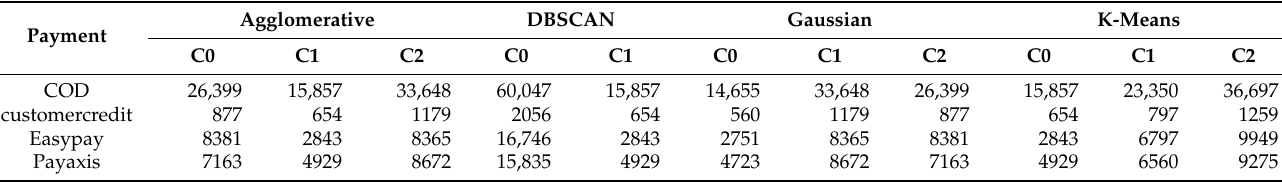
Table 9. Payment analysis for different algorithm clusters.